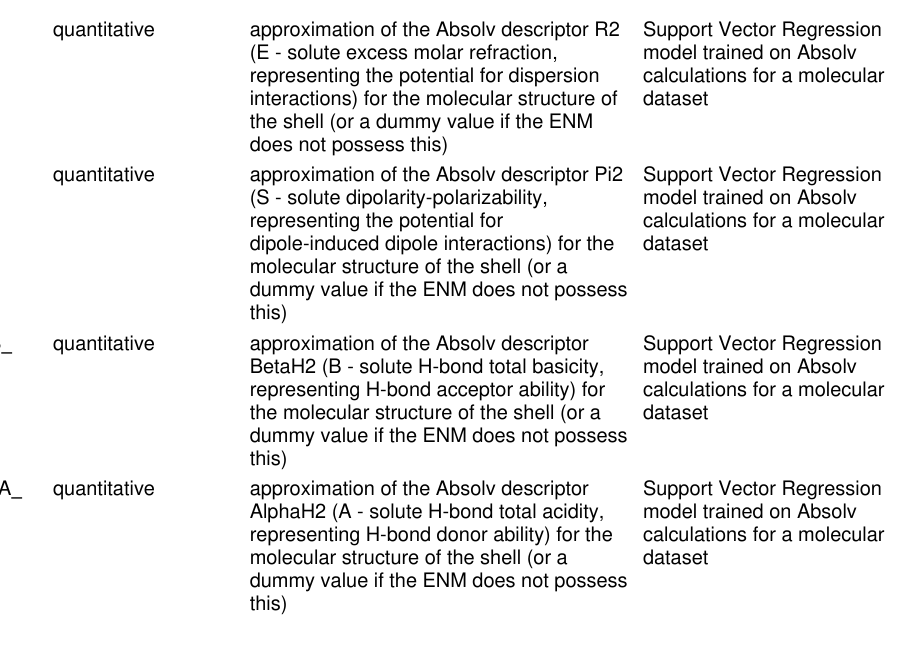
Table 3: Summary of all descriptor names, or prefixes for the one-hot-key encoded qualitative variables, reported in Supporting Information File 2, along with a description of how they were derived. (continued) Shell: